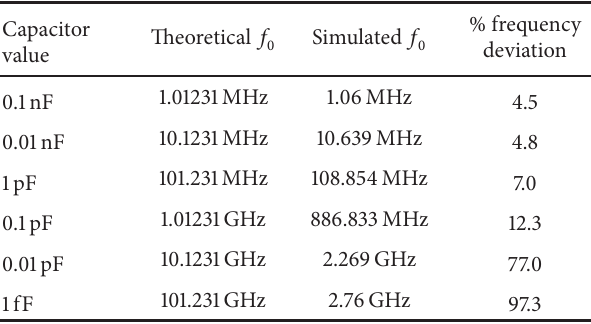
Table 3: The % frequency deviation for CM LP